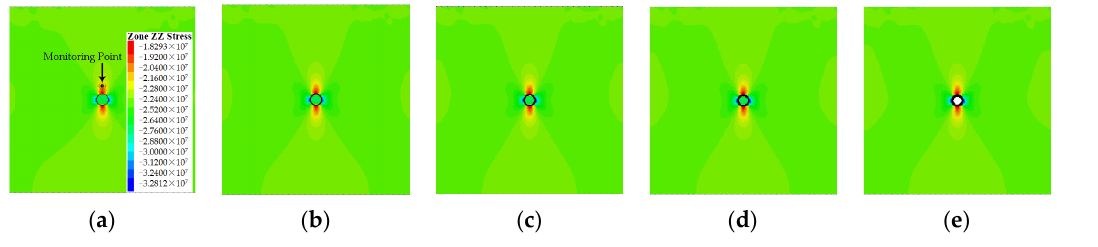
Figure 11. Vertical stress at different drilling depths. ( a ) 3 cm; ( b ) 6 cm; ( c ) 9 cm; ( d ) 12 cm; and ( e ) 15 cm.